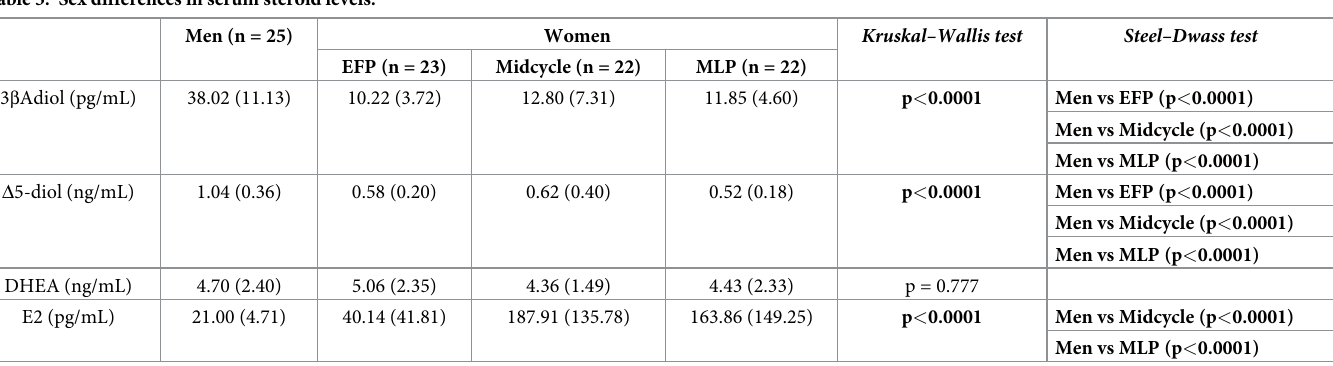
Table 3. Sex differences in serum steroid levels.